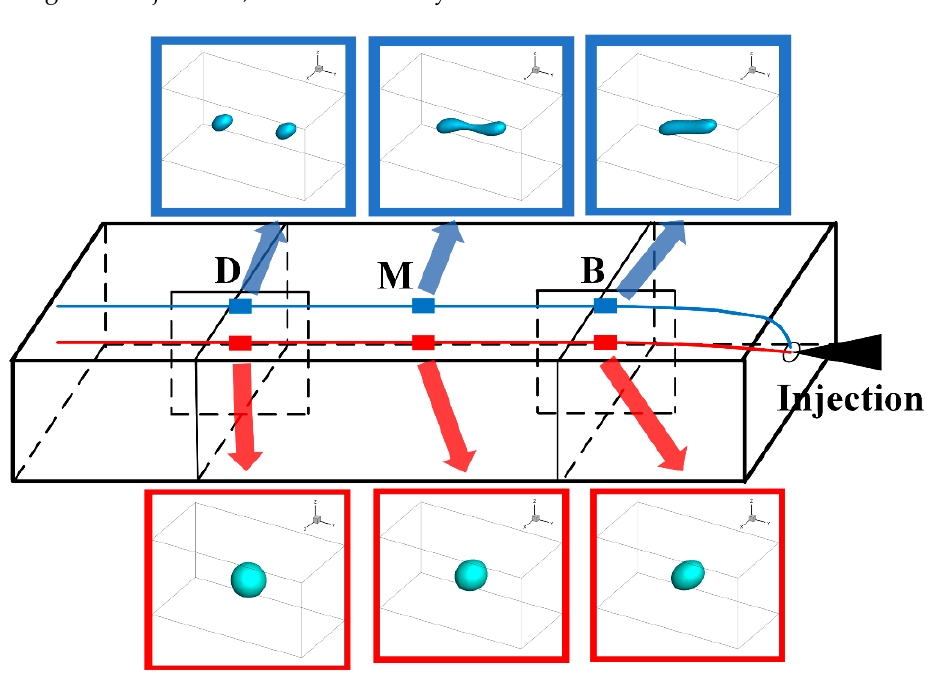
Figure 8. Droplet morphology evolution along their trajectories during mold-filling.